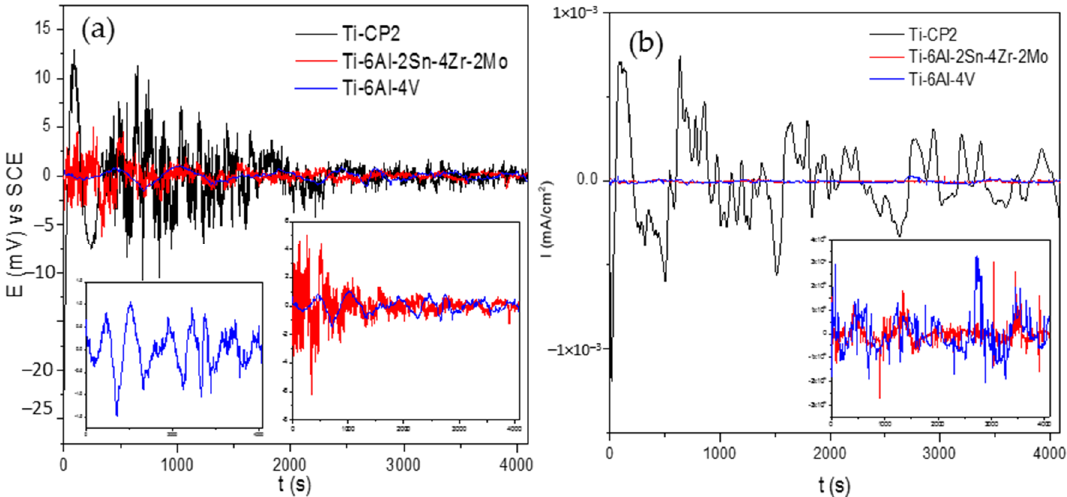
Figure 3. Time series EN data: ( a ) EPN and ( b ) ECN, in 3.5 wt. % H 2 SO 4 solution.